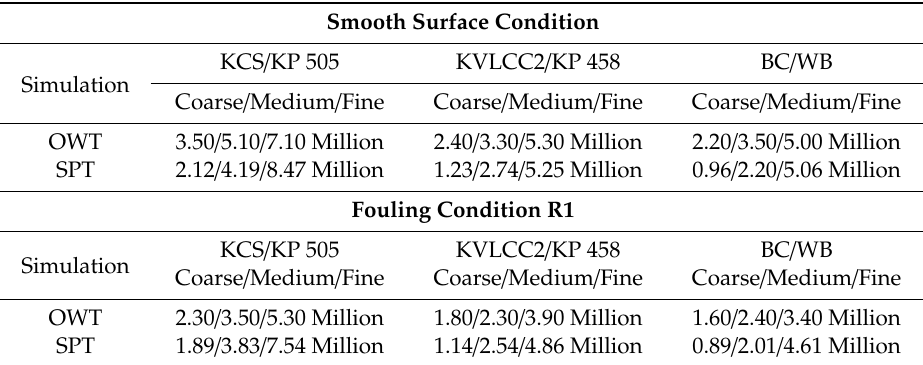
Table 4. Number of cells within CFD